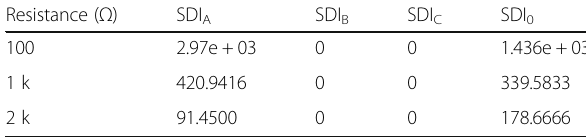
Table 1 SDI values during Ag at different fault